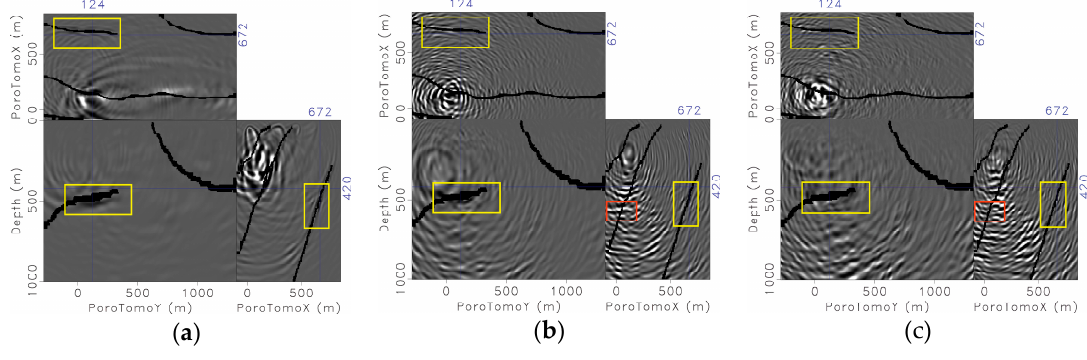
Figure 7. Deepest West-dipping Fault. Kinematics: P-wave Velocity Down & Up (P–P image) of ( a ) Wr = synthetic 4 fault model and ( b ) Wr = Field Brady’s field data ( c ) Wr = Pure Noise.